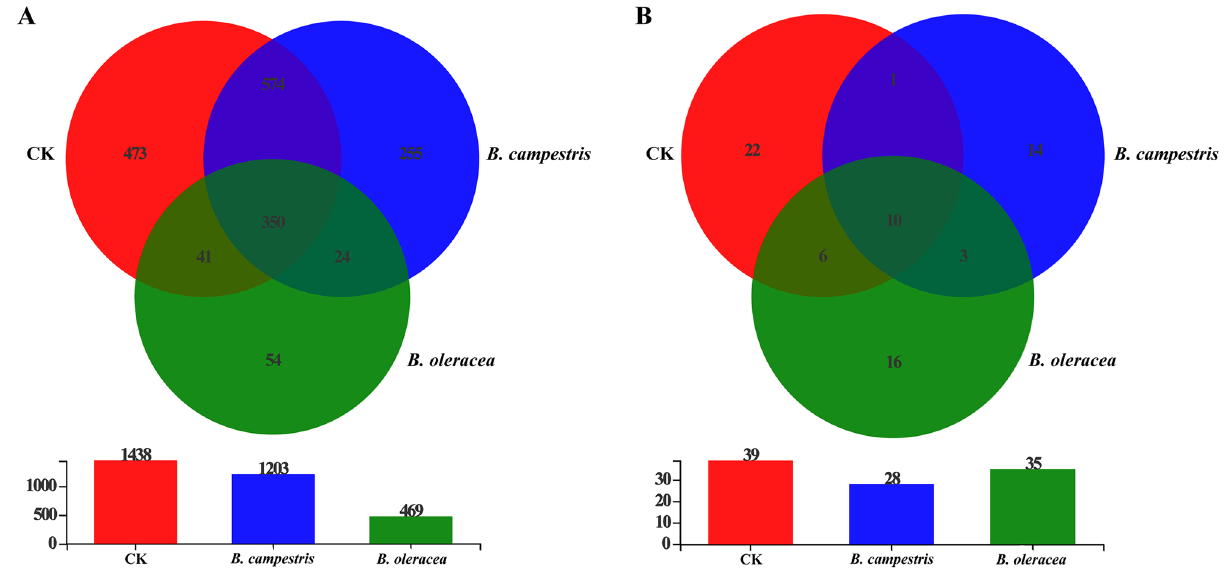
Figure 3. The analysis of the number of microbial species in different groups. ( A ) A Venn diagram and histogram of the bacterial species in different groups. ( B ) A Venn diagram and histogram of the fungal species in different groups. Red rings represent the species from the control group, blue rings represent the species from the group fed on B. campestris , and green rings represent the species from the group fed on B. oleracea, respectively. The figure was created by jvenn (version 1.0) (http:// www. bioin forma tics. com. cn/ static/ others/ jvenn/ examp le. html.).